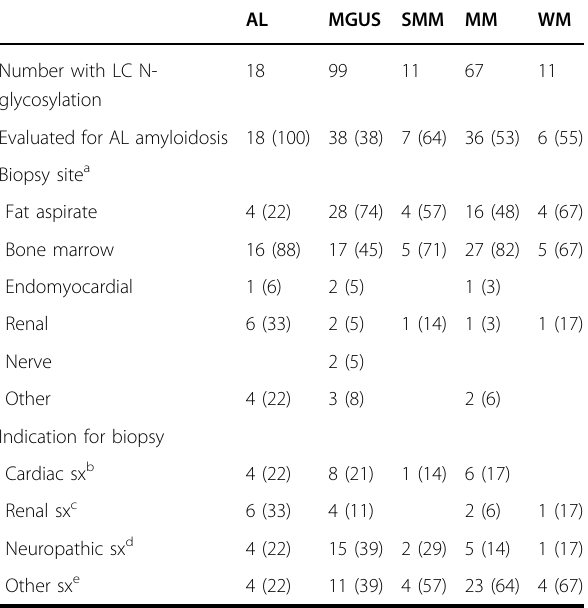
AL amyloidosis by diagnosis with biopsy site and